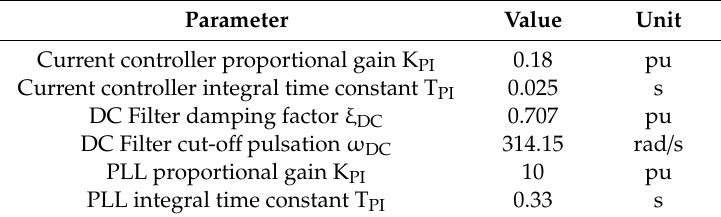
Table 6. TVFD controller’s